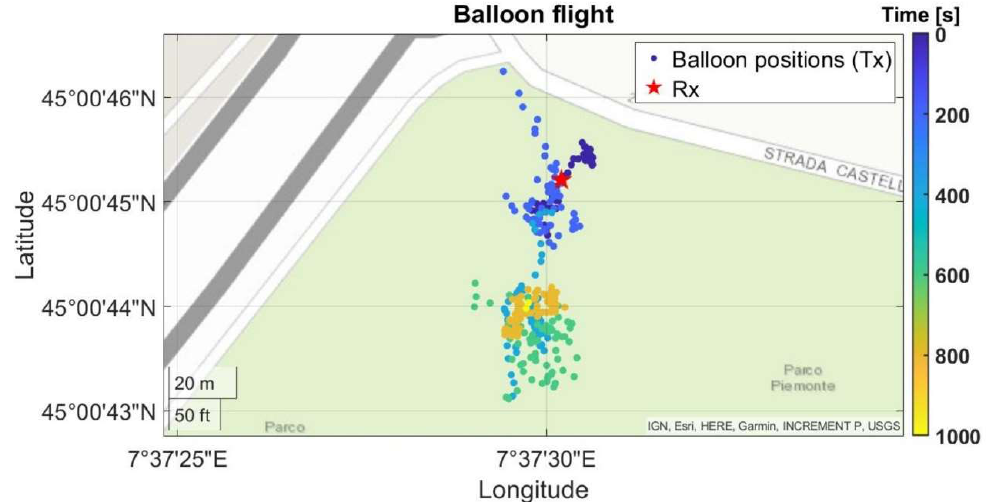
Figure 11. Low-atmosphere trajectory of the fully operational radioprobe inserted in a helium-filled biodegradable balloon, displayed on a map. The color bar indicates the elapsed time.